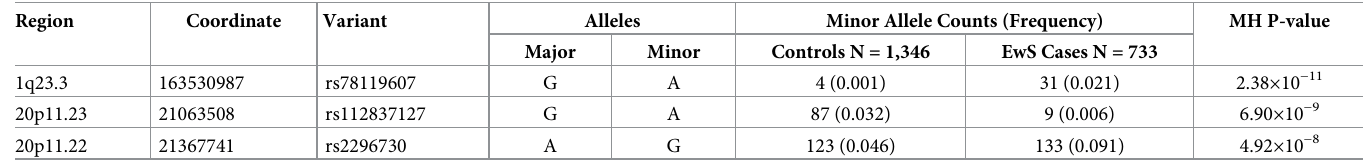
Table 1. Genome-wide significant associations (P-value < 5 × 10 − 8 ) for identified low-frequency and rare variants with EwS susceptibility using a dominant model stratified by study. Region